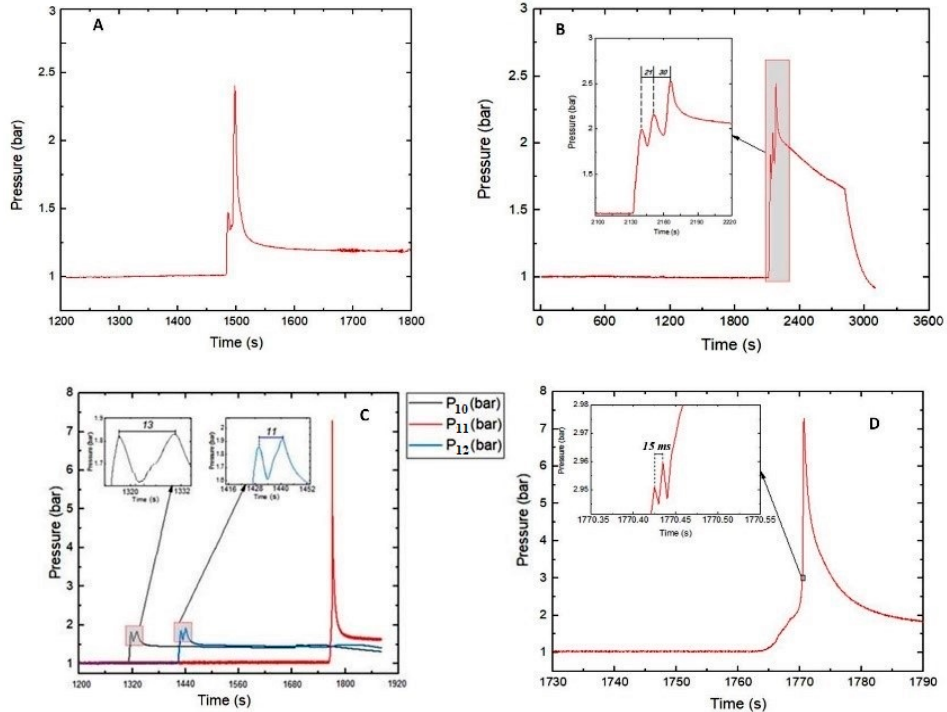
Figure 1. p max for: ( A ) Single 10 Ah cells from Series 1 in the range of 80–89% SOC with a glow plug